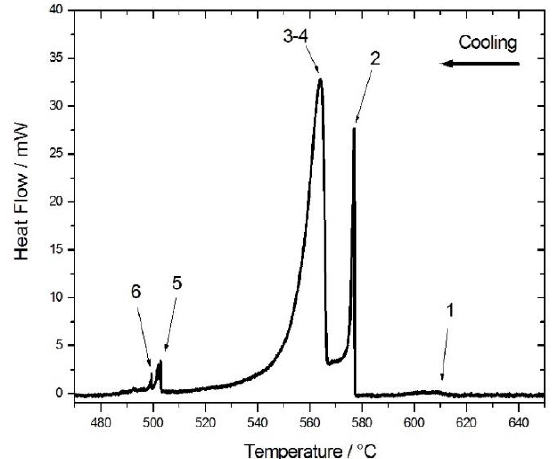
Figure 4. Differential scanning calorimetry curve of experimental AlSi9Cu3(Fe) alloy recorded during cooling at 2 °C/min; peak 1 = primary Fe- rich phase; peak 2 = α -Al crystals; peaks 3 and 4 = eutectic Si and Fe-containing phases; peak 5 = Al 2 Cu phase; peak 6 = eutectic structures containing Al 2 Cu and Al 5 Mg 8 Si 2 Cu 2 .